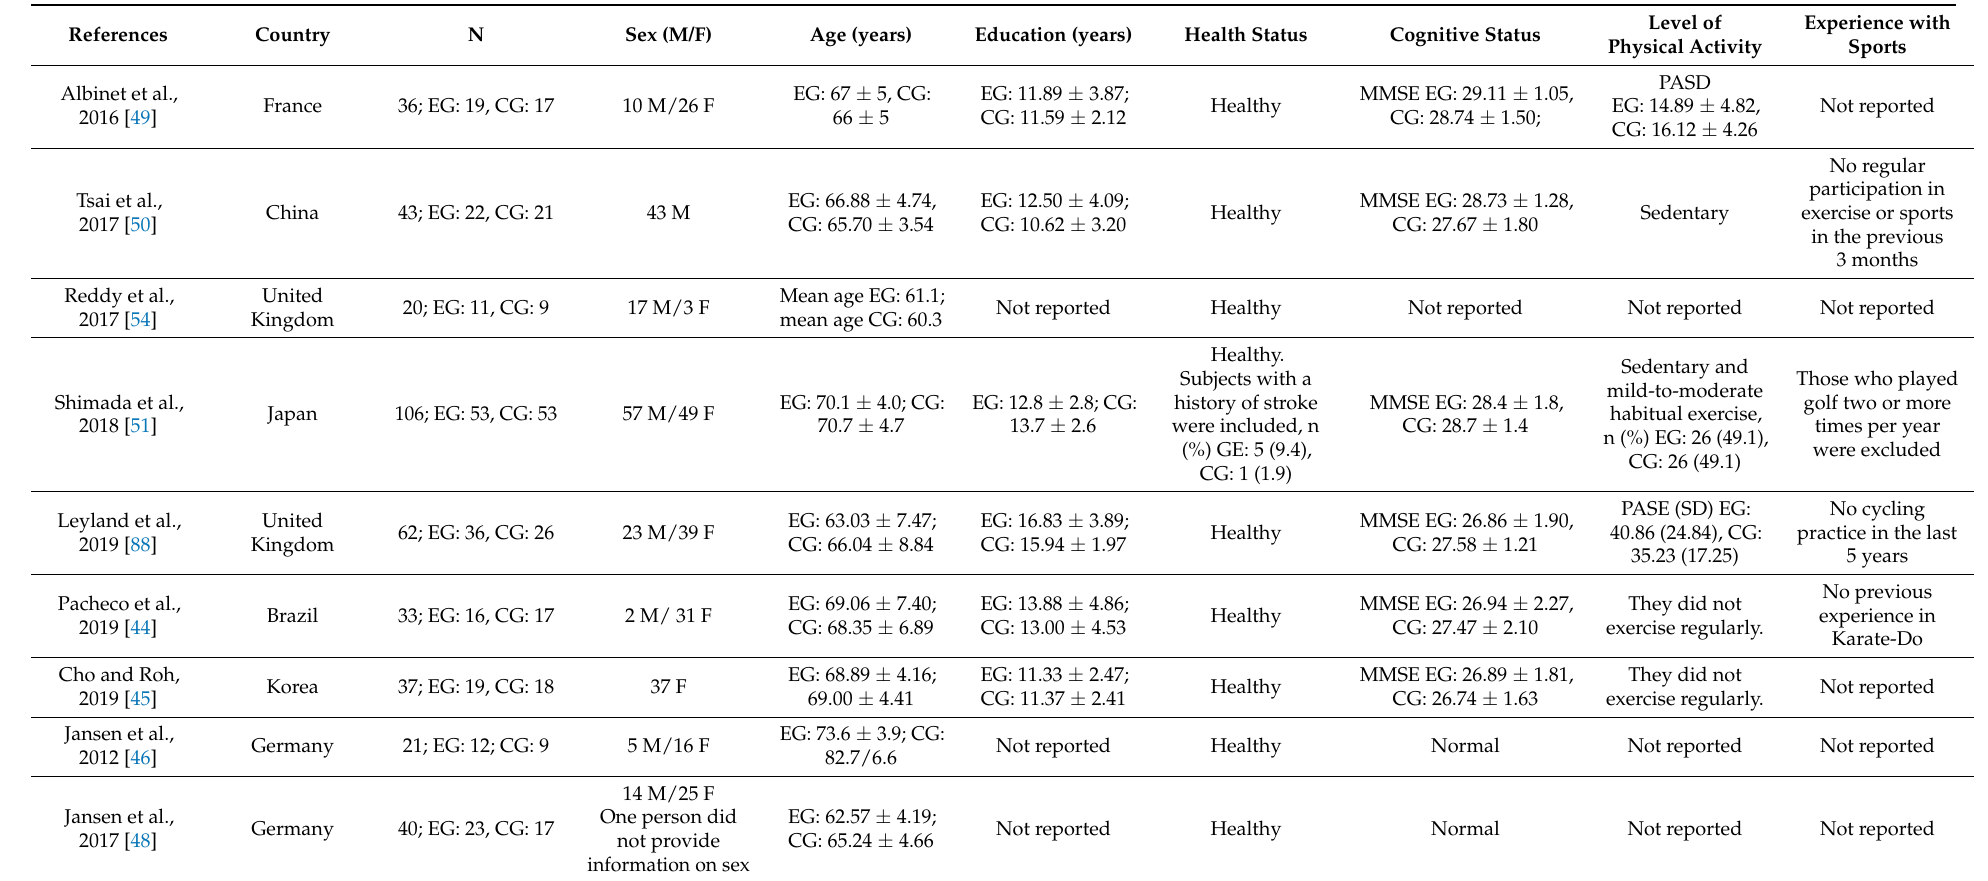
Table 2. Subjects’ characteristics from the included